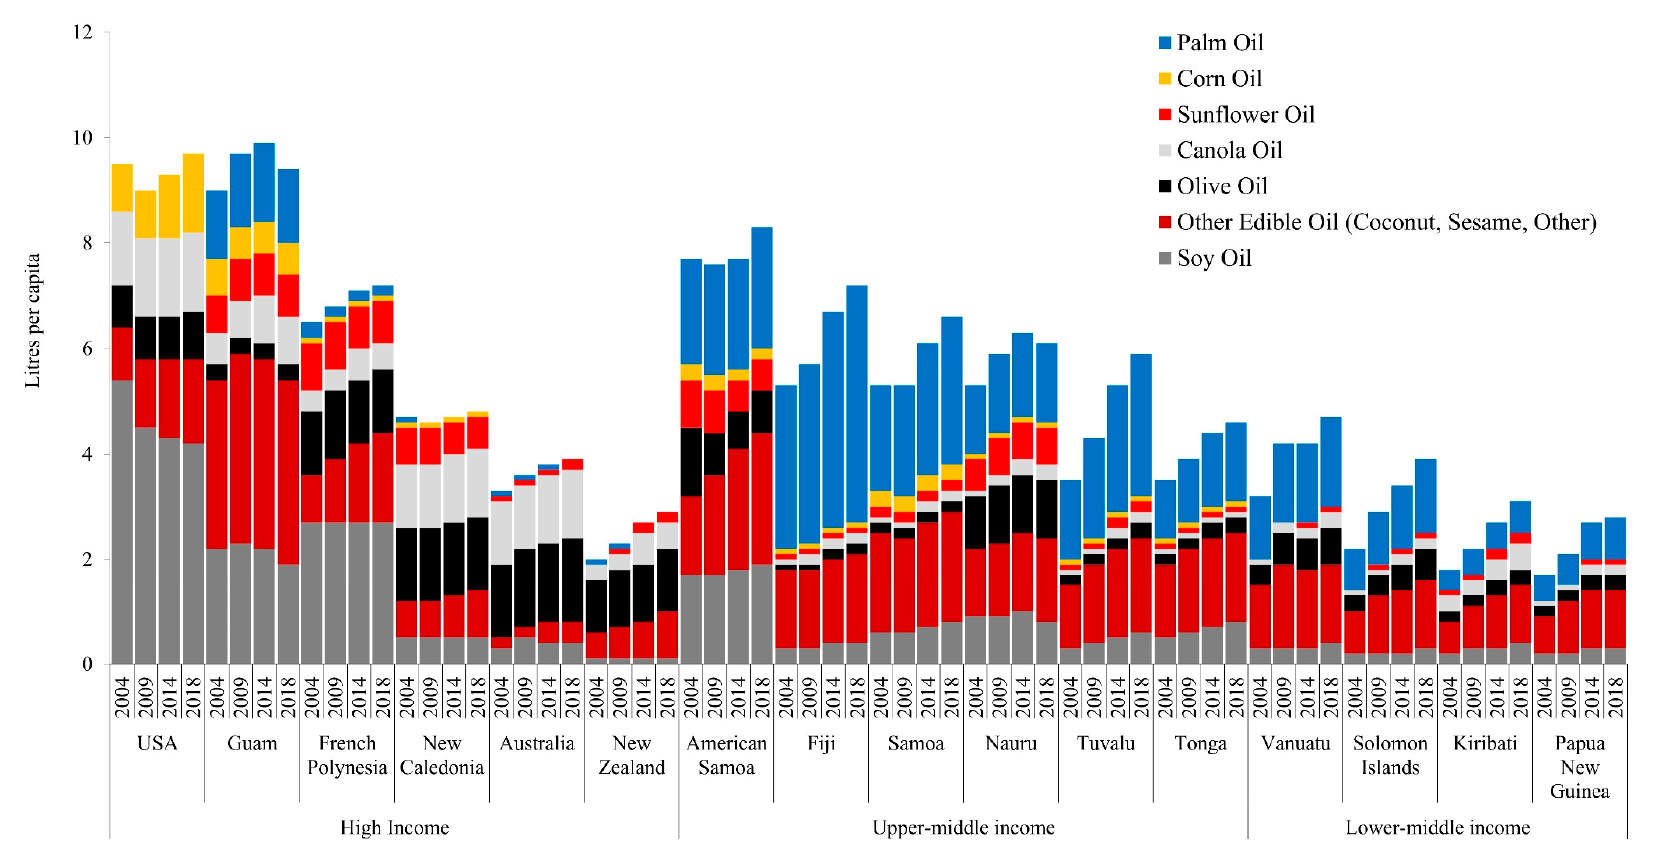
Figure 3. Per capita vegetable oil sales in Pacific island countries, 2004–2018, by country income level.